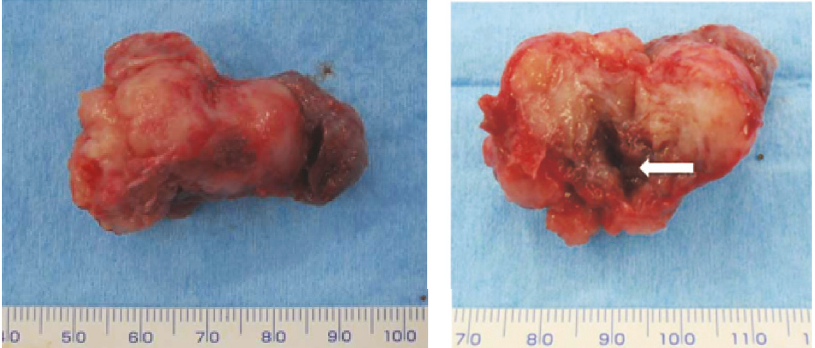
Figure 4: The surgical specimen had a gourd-like shape, and its cross section contained a solid portion and a cystic lesion